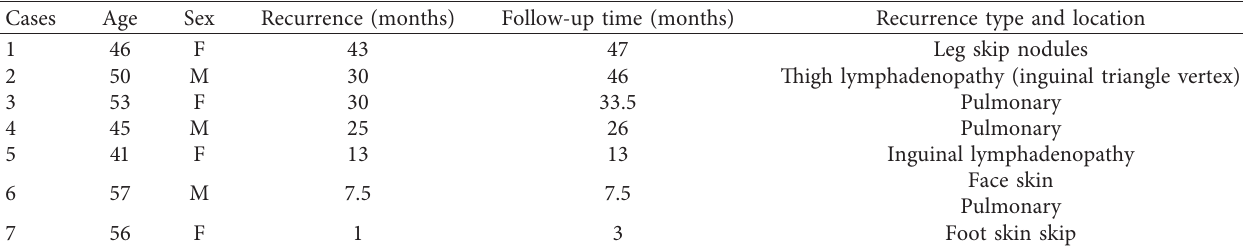
Figure 4: Cutaneous skip metastasis recurrences. (a) Cervical skip metastasis in a 57-year male and (b) leg skip metastasis in a 46-year female. Table 1: Recurrences after